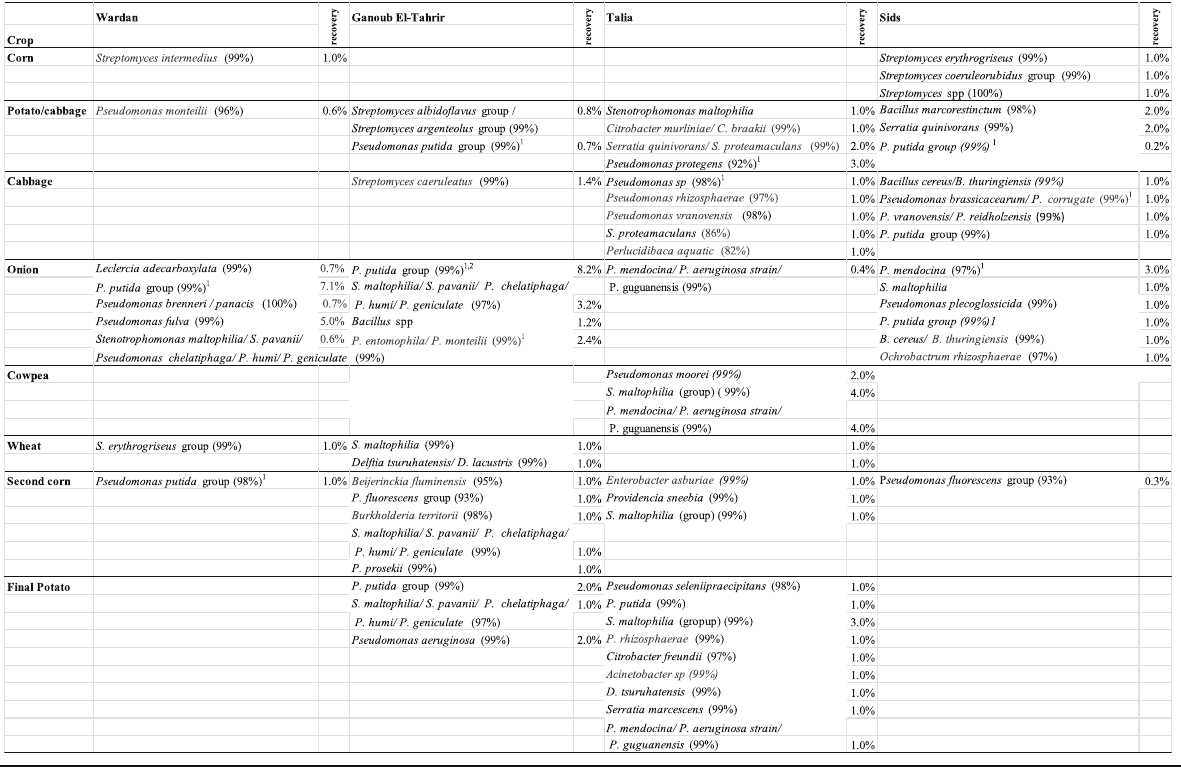
Identification was made by DNA sequencing either for the V6 to V8 region of the 16S rRNA gene as described in Hiddink et al. (2005) or by MicroSeq®500 (16S rDNA microbial identification kit) provided by Applied Biosystem using 8-capillary Genetic Analyzer ( Applied Biosystem